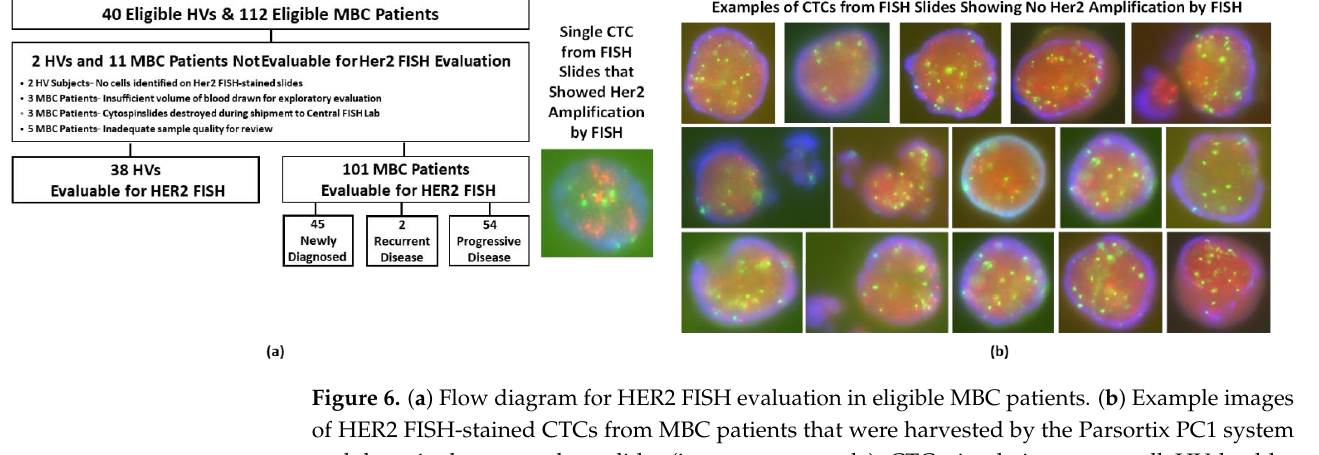
Figure 6. ( a ) Flow diagram for HER2 FISH evaluation in eligible MBC patients. ( b ) Example images of HER2 FISH-stained CTCs from MBC patients that were harvested by the Parsortix PC1 system and deposited onto cytology slides (images not to scale). CTC, circulating tumor cell; HV, healthy volunteer; MBC, metastatic breast cancer; FISH, fluorescence in situ hybridization.